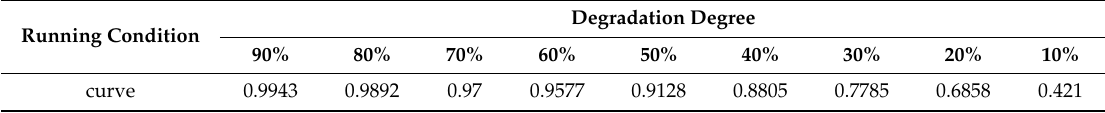
Table 5. WPCC coe ffi cients under German railway spectra of high Table 4. WPCC coefficients under curve condition.